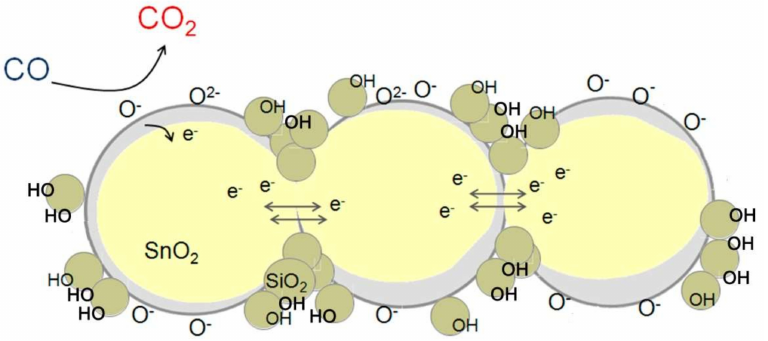
Figure 13. Schematic representation of the process of CO oxidationizing on the surface of SnO 2 /SiO 2 nanocomposite under wet